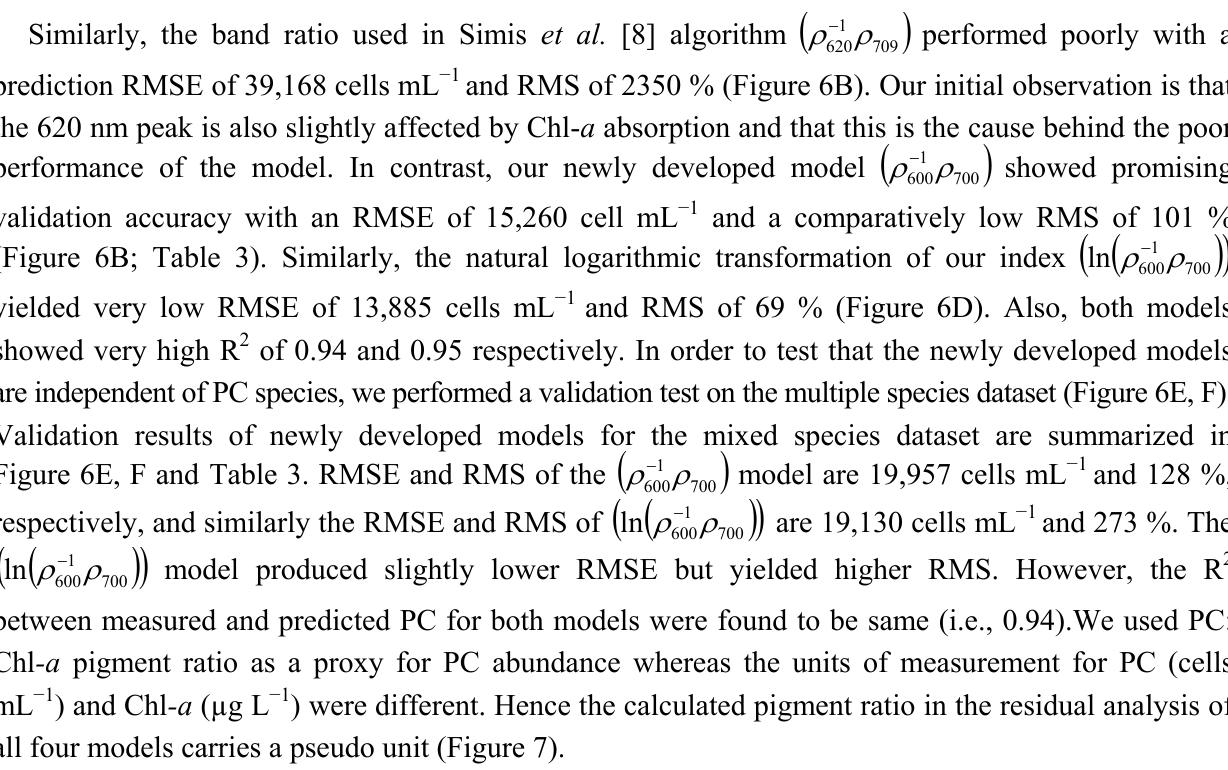
Figure 7. Comparative scatter plots of PC residuals versus PC:Chl -a ratio for four spectral indices such as, A.